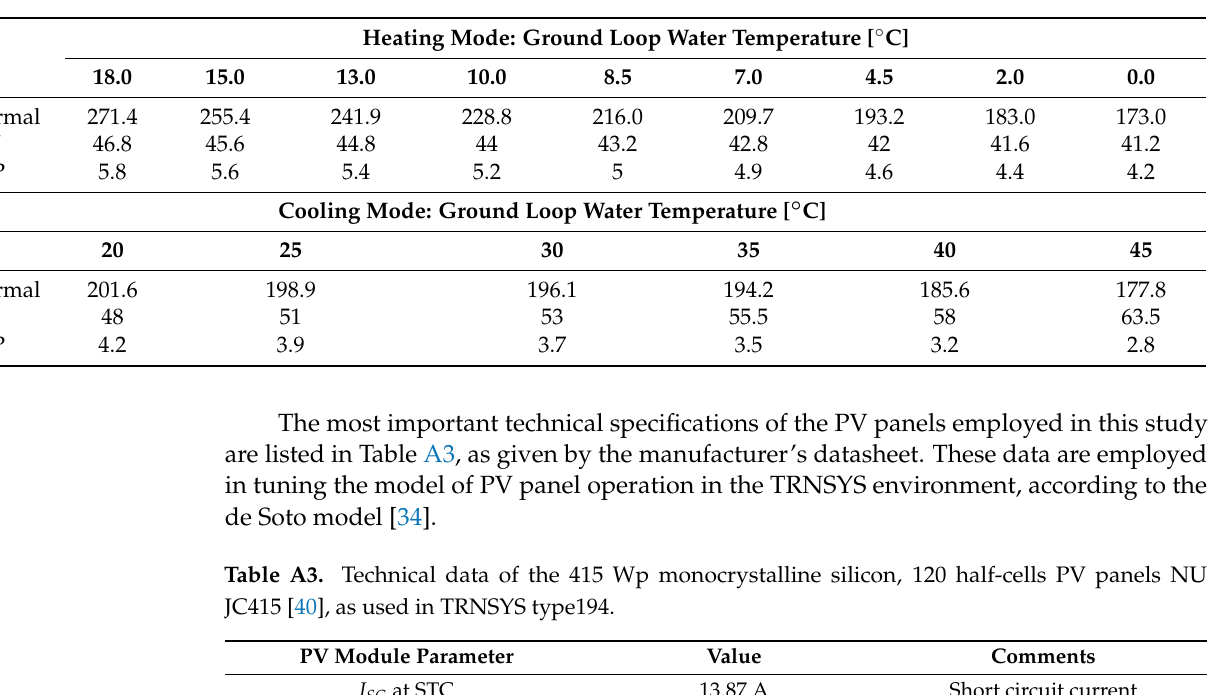
Table A2. Water–water heat pump efficiency data for heating and cooling modes.